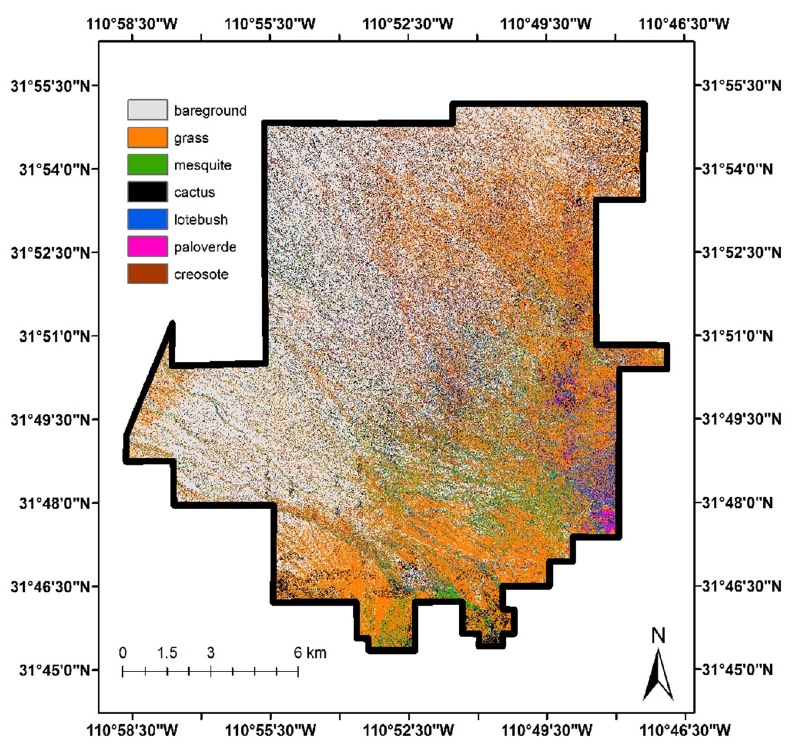
Figure 3. SRER species classification results based on 3 years of hyperspectral and LiDAR data.